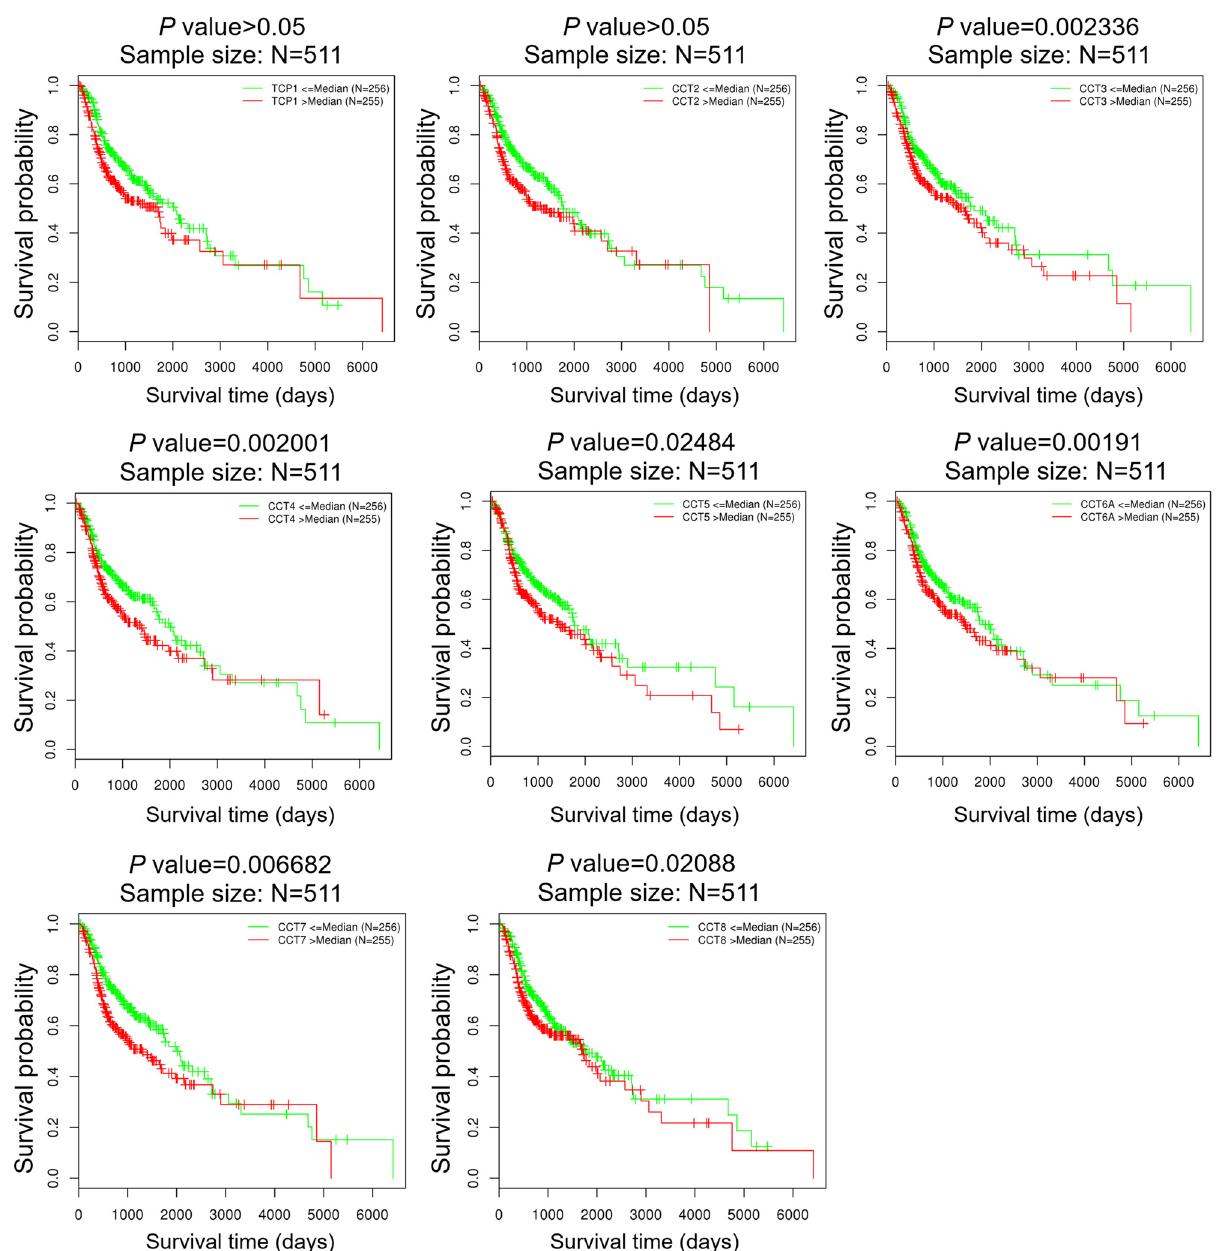
Figure 4: The prognosis value of CCTs in HNSC patients ( LinkedOmics ) . The prognosis value of mRNA expression levels of CCTs in HNSC patients, analyzed by